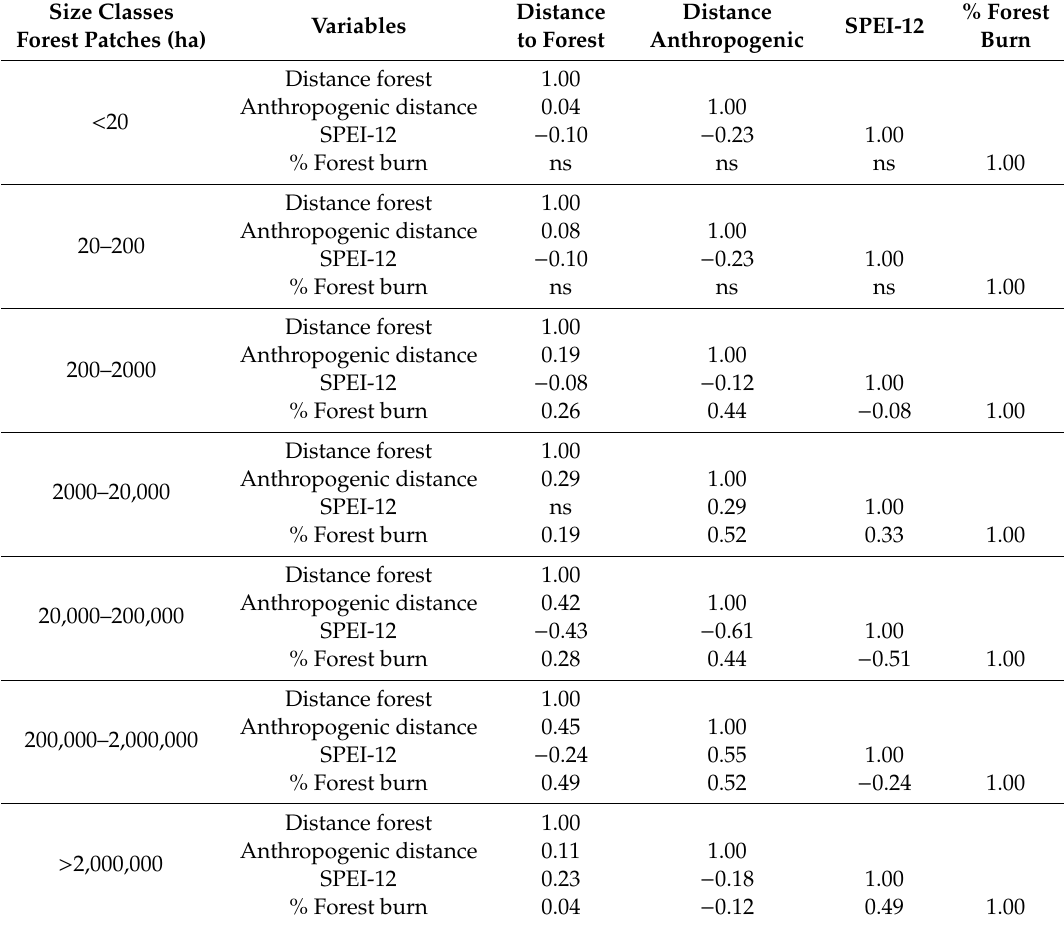
Table A1. Spearman (Rho) correlation between forest patch size classes, distance (forest edge and anthropogenic), forest burn (%) and drought variables